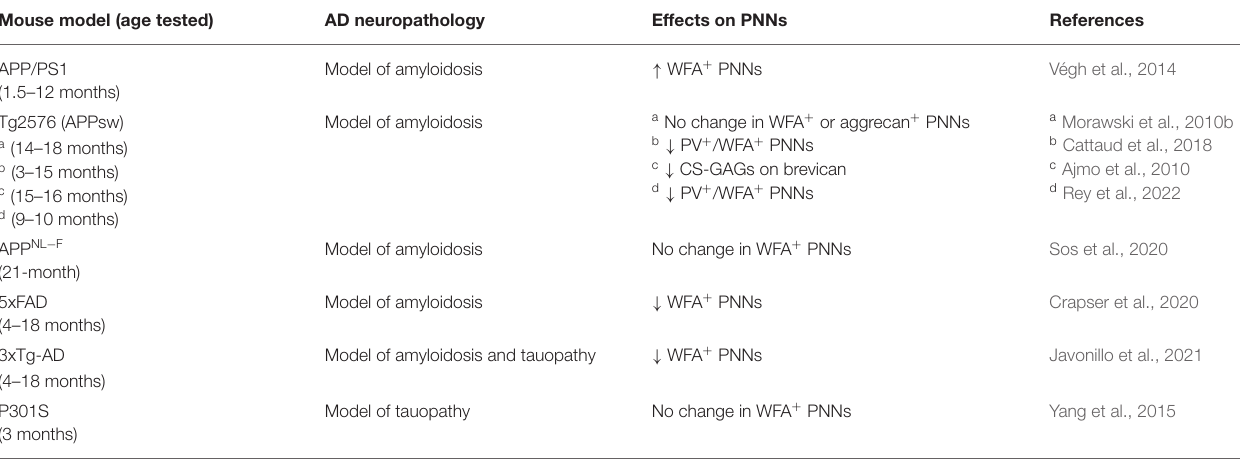
TABLE 2 | PNN Changes in mouse models of AD